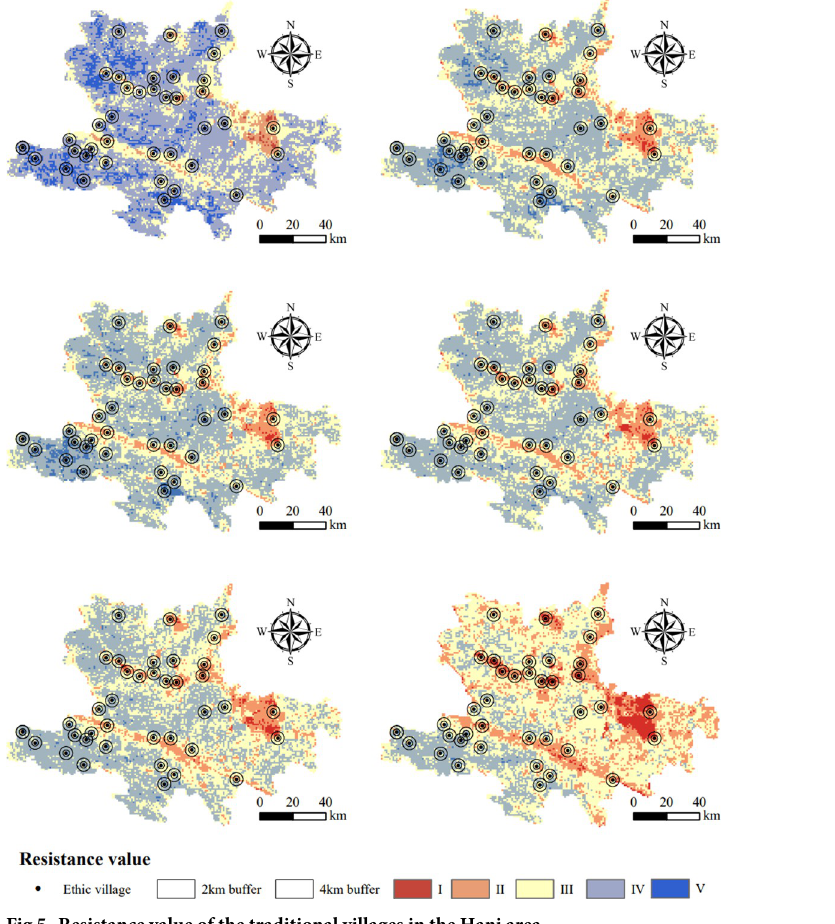
Fig 5. Resistance value of the traditional villages in the Hani